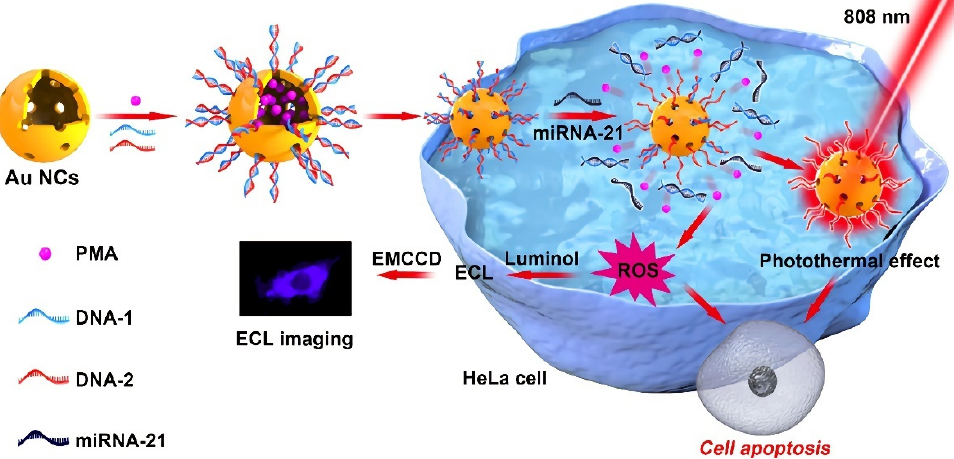
Figure 3. Schematic diagram of the microRNA-responsive AuNCs@PMA probe for controlled drug release, ECL imaging, and combined therapy. Reprinted/adapted with permission from Ref. [48]. Copyright 2019, American Chemical